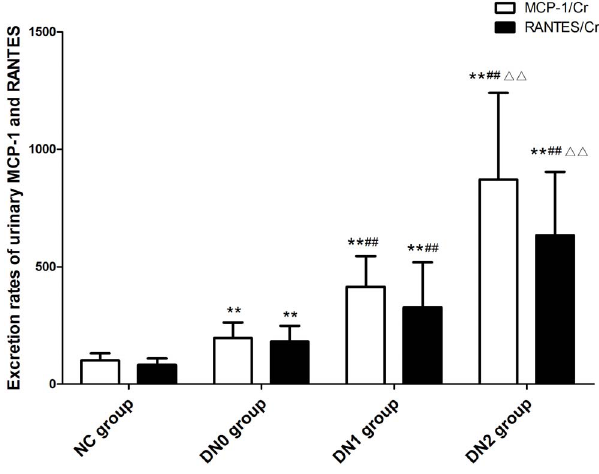
Figure 4. Correlation between urinary MCP-1 excretion rate and (a) nuclear NF- k B p65 protein, (b) NF- k B p65 mRNA or (c) eGFR.